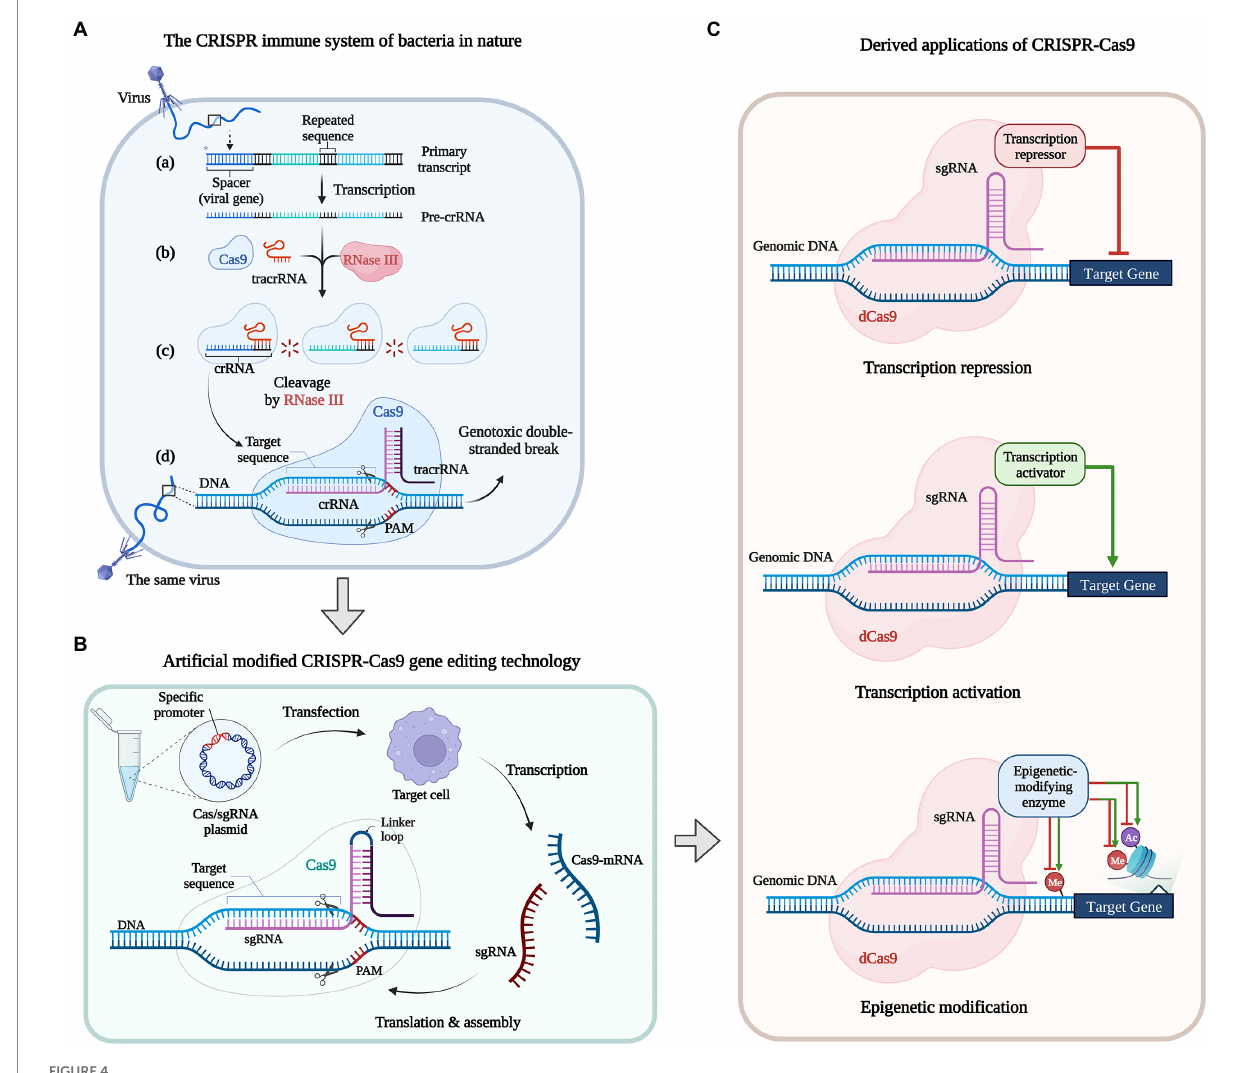
FIGURE 4 Development of the CRISPR-Cas system: natural, modified, and derived applications. (A) The CRISPR immune system of bacteria in nature. (a) Viral DNA is inserted into the bacterial genome as a spacer in between the repeated CRISPR sequences. (b) Trans-activating RNA (tracrRNA) recognize CRISPR-RNA (crRNA) sequences and target Cas9 enzymes to the crRNA. (c) The crRNA: tracrRNA duplex cleave the longer pre-crRNA by RNaseIII and then produce mature crRNA. (d) When the same virus infect bacterium again, the Cas9: crRNA generated during the first infection recognizes Protospacer Adjacent Motif (PAM) motifs in the viral genome, enabling target-DNA recognition and Cas9-mediated cleavage to prevent the re- infection. (B) Artificial modified CRISPR-Cas9 gene editing technology. In vitro designed Cas/ single guide RNA (sgRNA) expression plasmid(s) with specific promoters are transduced into target cells, Cas/sgRNA mRNAs are transcribed in vivo , which are translated, modified, and assembled to form a CRISPR-Cas9 system. (C) Derived applications of CRISPR-Cas9. dead Cas9(dCas9) can be used to mediate transcriptional repression, activation and epigenetic modification of target genes when fused with a small-molecule repressor, activator and epigenetic-modifying